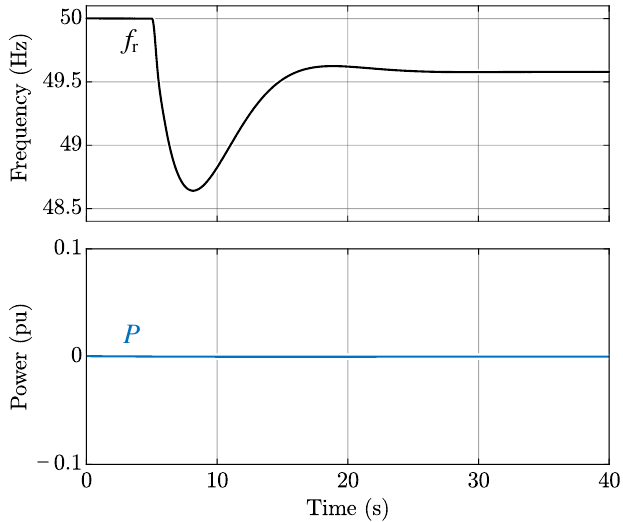
Figure 16. Simulated frequency regulation tests. The Distribution Static Synchronous Compensator (D-STATCOM) does not react to the grid frequency